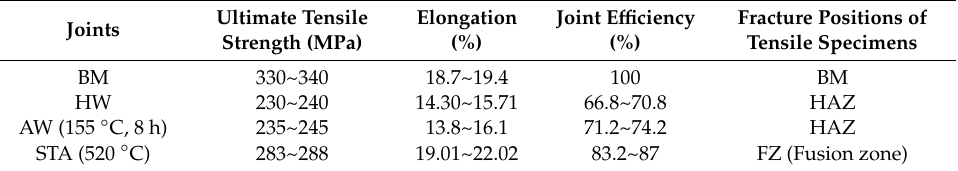
Table 5. Transverse tensile properties of laser–arc hybrid welded 6061-T6 joints.